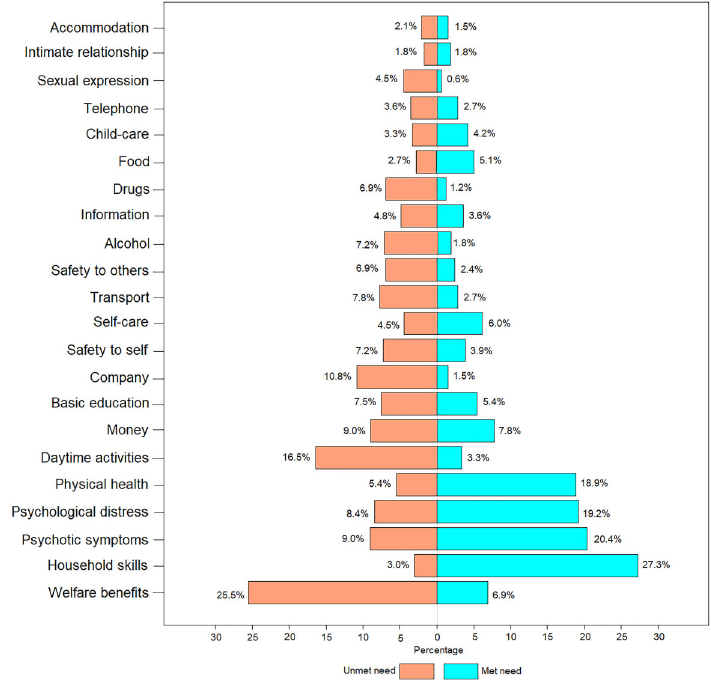
Figure 2. Bar plot of the distribution of needs (met and unmet) in each of the 22 domains of Camberwell Assessment of Need – Research version (CAN-R) for the 333 interviews (in percentage).